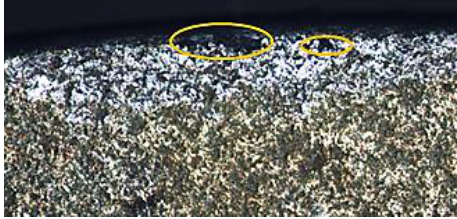
Figure 13. Slight tool wear observed when finish milling the workpiece built with the SSR of 67° with v c = 30 m/min, f = 0.1 mm/tooth/rev when milling in the XZ plane.